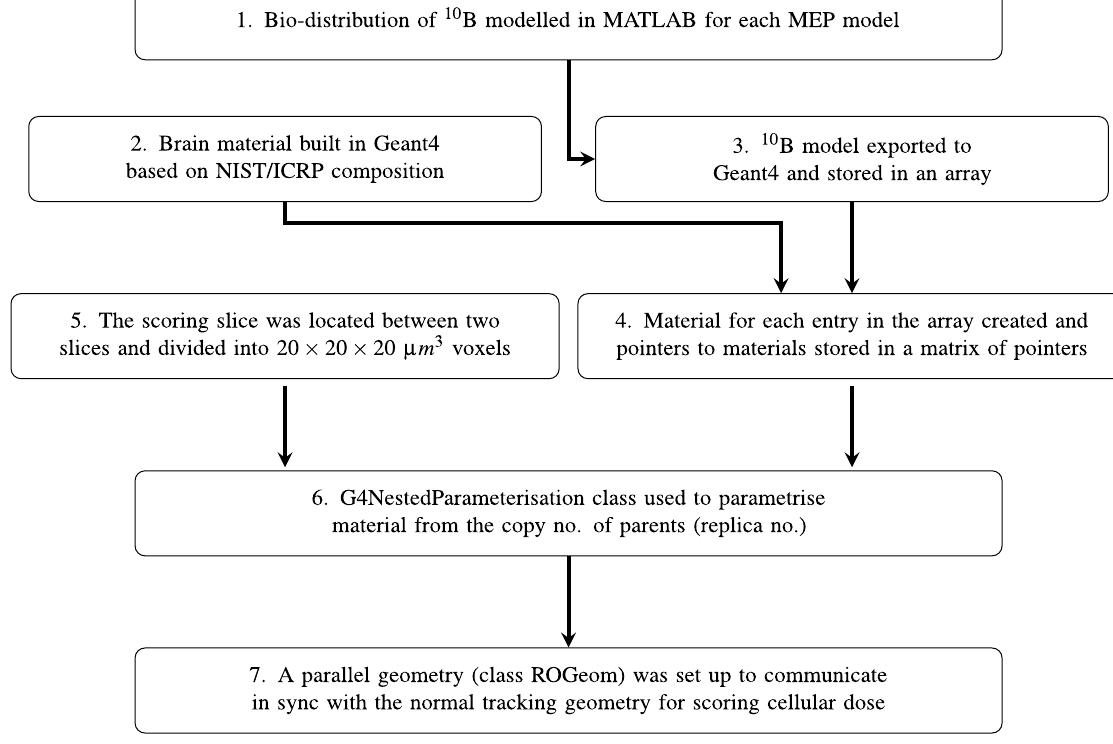
Figure 7. Schematic diagram showing the architecture of the geometry of Geant4 cell-based dosimetry system in the current work.